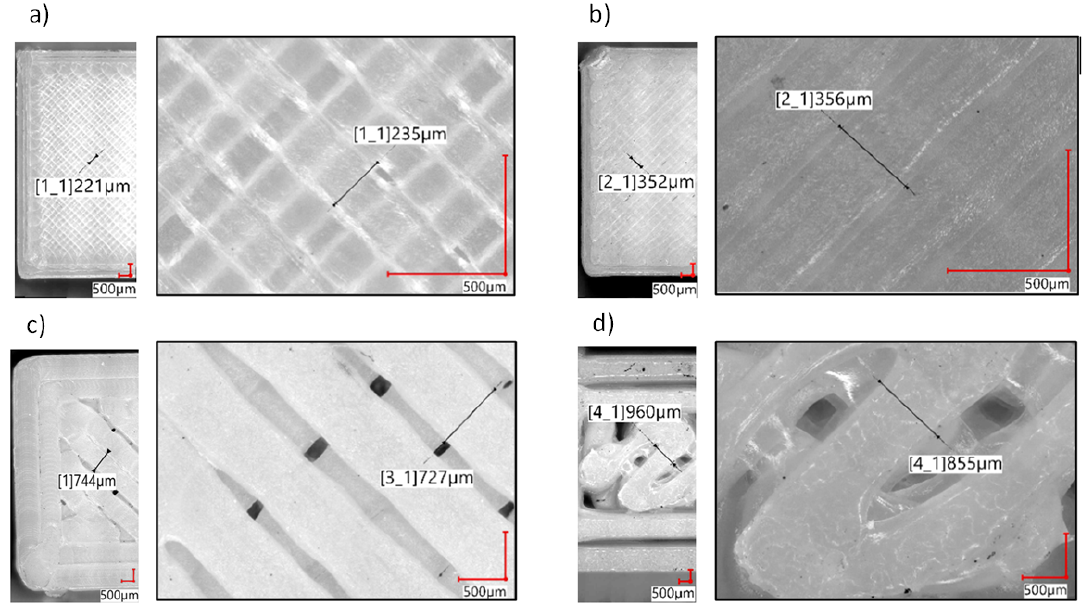
Figure 7. Microscope images of the outer layer of tested specimens with example path width measured: ( a ) 0.2 mm diameter nozzle, ( b ) 0.4 mm diameter nozzle, ( c ) 0.8 mm diameter nozzle, ( d ) 1.2 mm diameter nozzle.